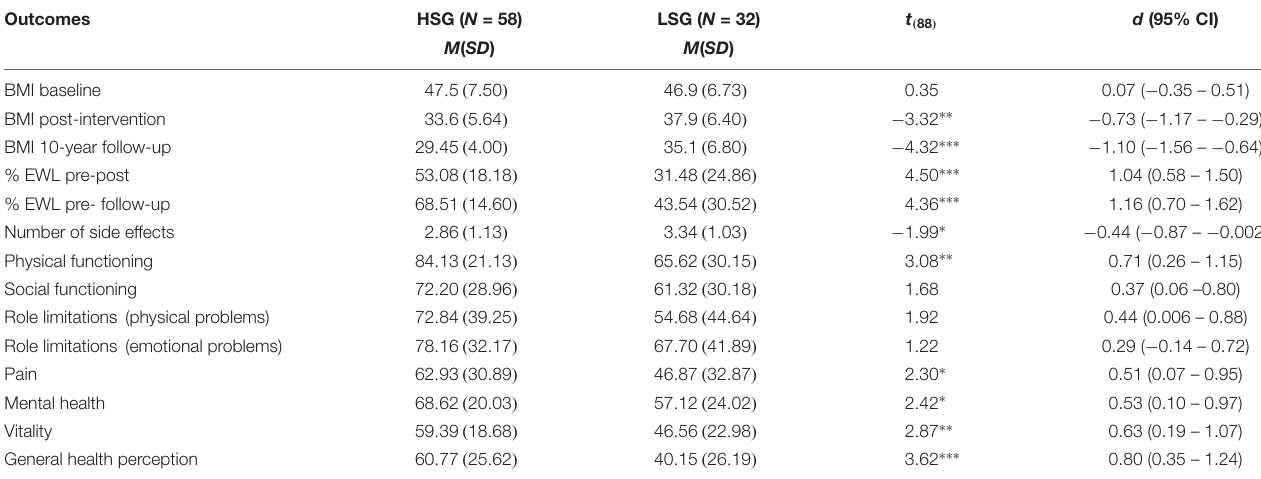
TABLE 2 | Study outcomes in relation to intervention